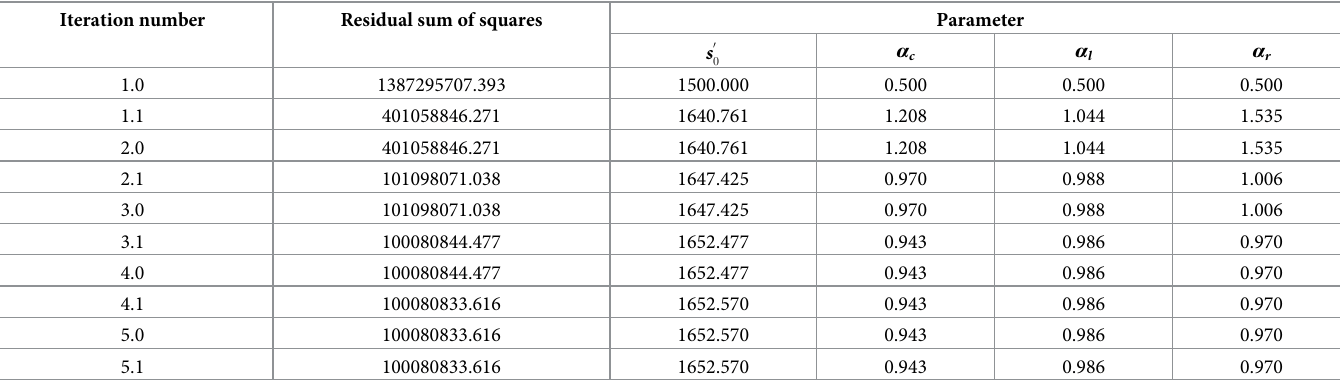
Table 3. Iteration procedure results. Iteration number